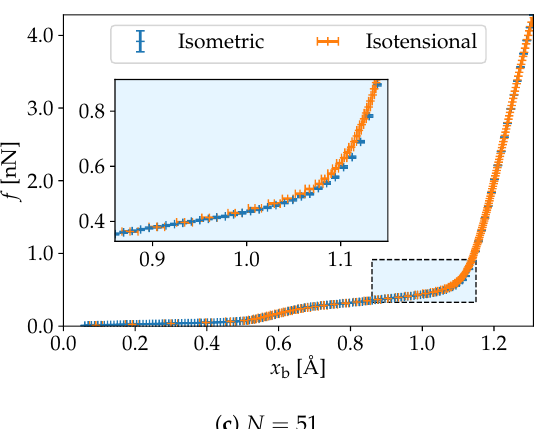
Figure 1. Force as a function of length per bond from isometric and isotensional simulations for chains of poly-ethylene oxide (PEO) composed of N = 12, 24 and 51 united atoms. The ensemble inequivalence is most pronounced for the smallest